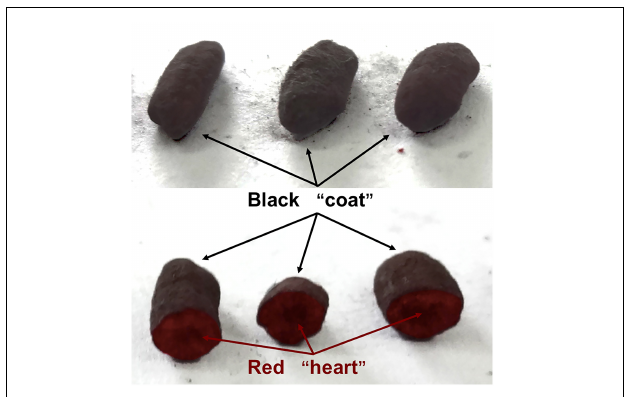
FIGURE 1 | Appearance and cross-sections of black-skin-red-koji